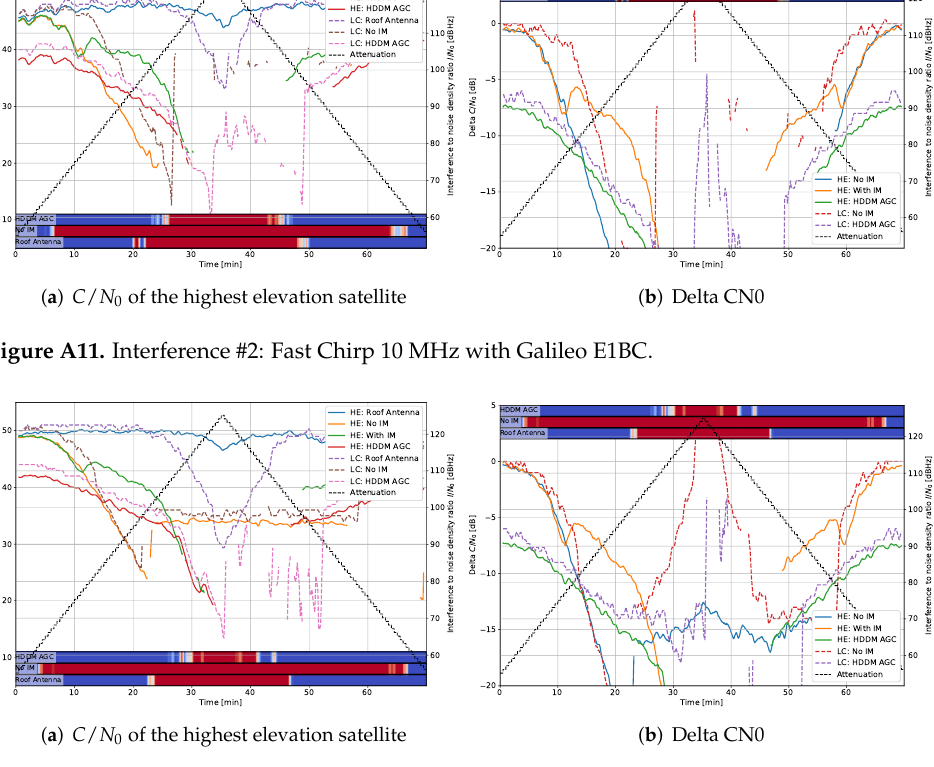
Figure A12. Interference #3: Slow Chirp 10 MHz with Galileo